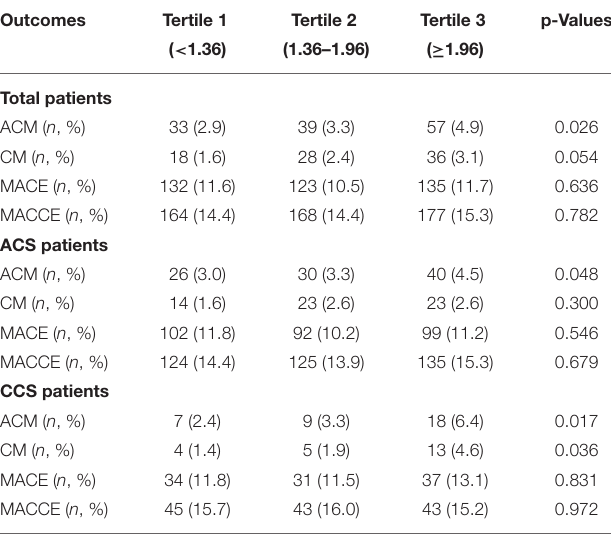
TABLE 2 | Outcome comparison between groups.